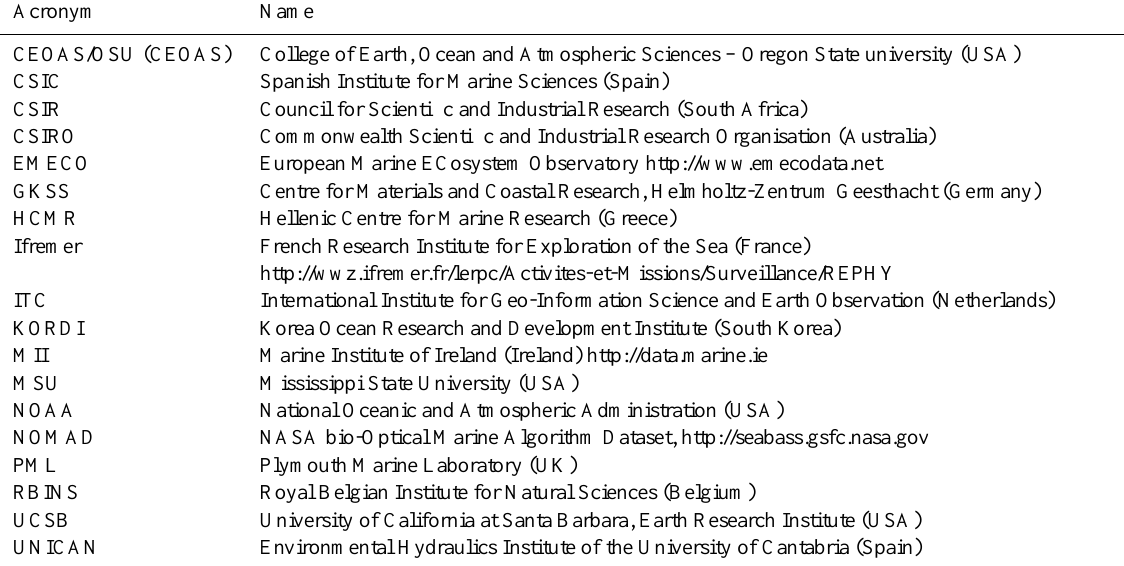
Table 1. Acronyms of in situ data sources, as well as associated websites where the original data and methodologies are available.